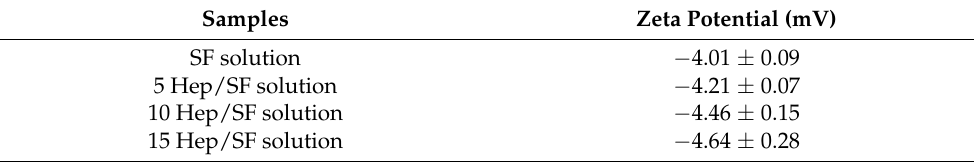
Table 1. Zeta potential of silk fibroin (SF) and heparin-silk fibroin (Hep/SF)